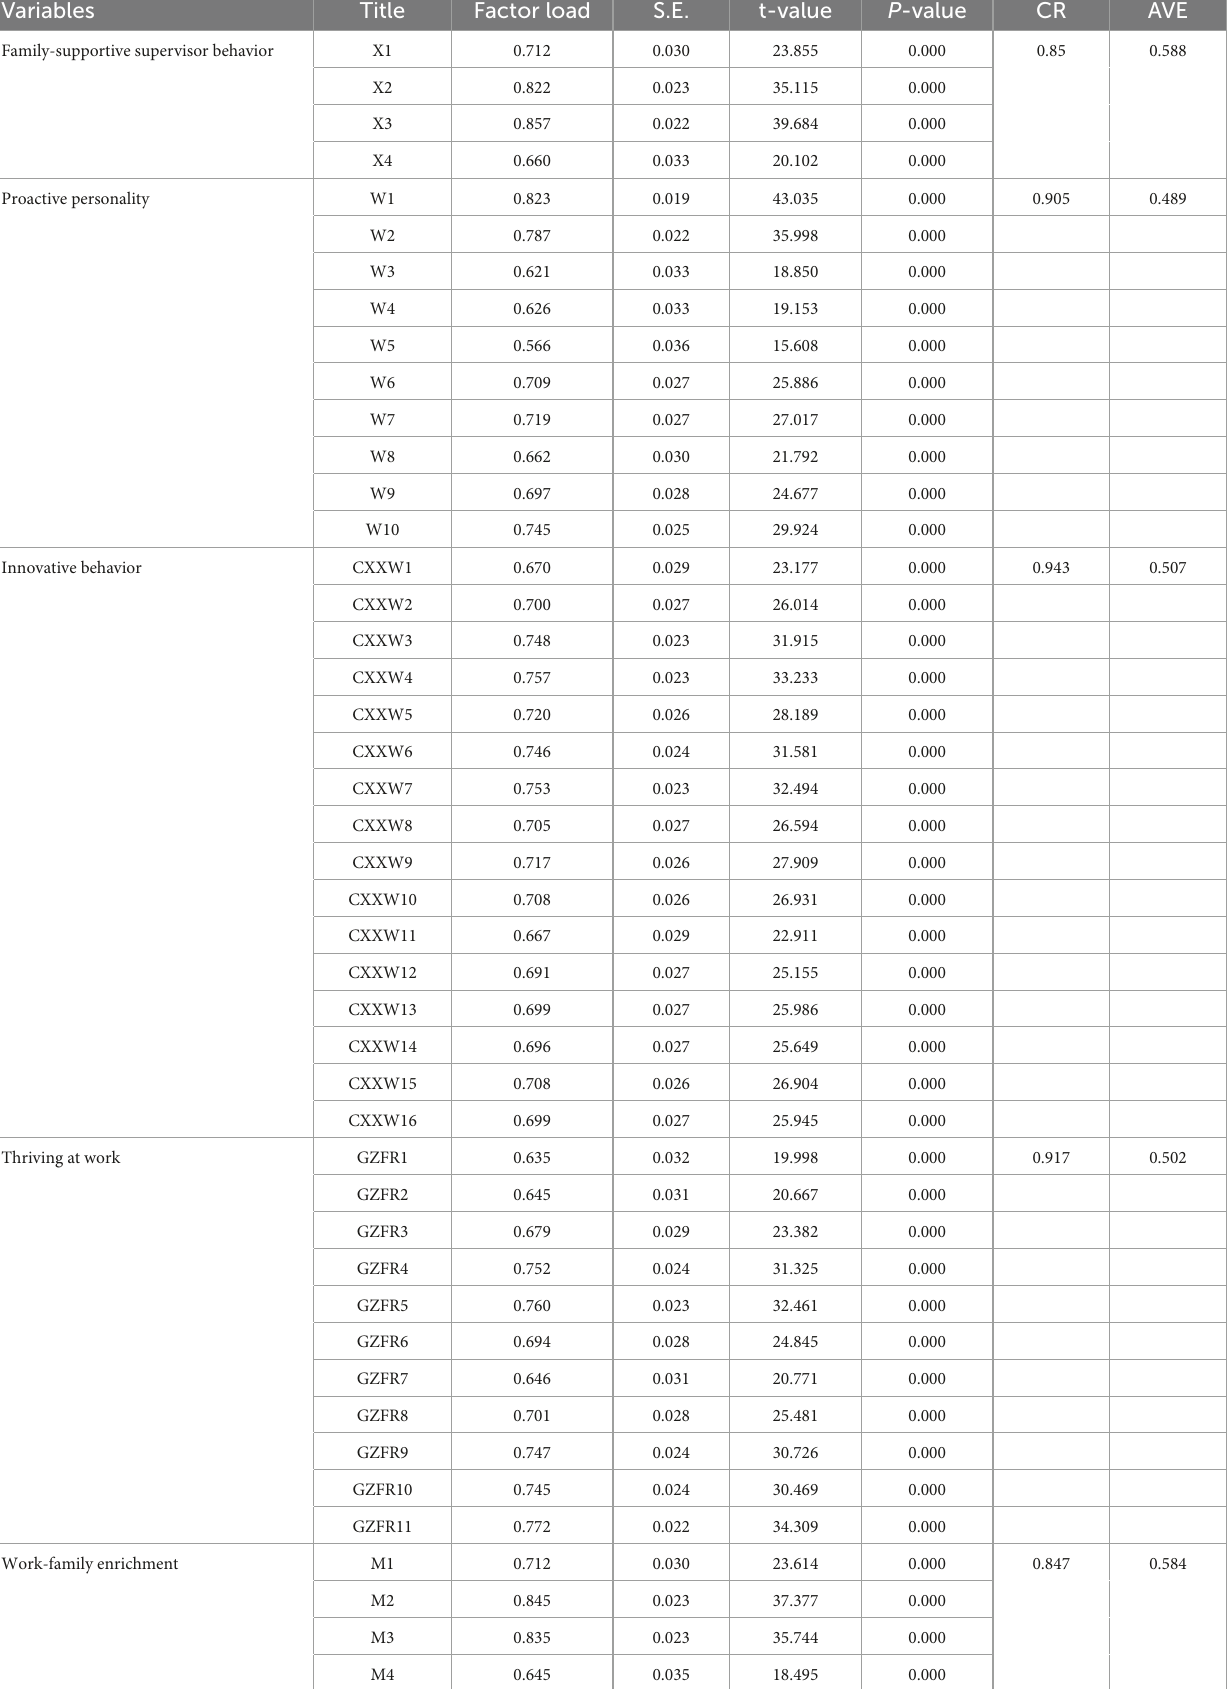
TABLE 3 Convergent